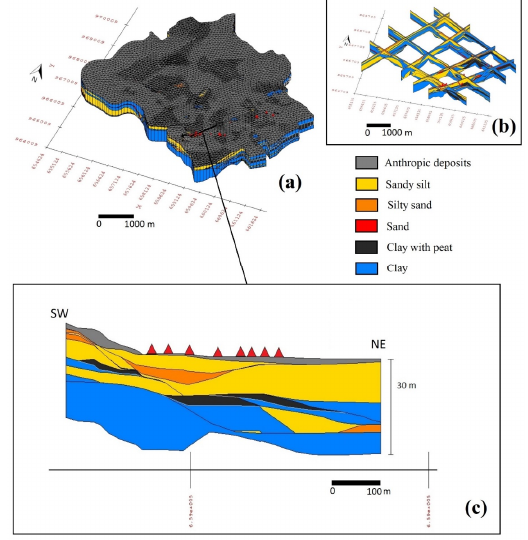
Figure 11. ( a ) The 3D engineering geological model of Cavezzo and fence diagram of geological sections, derived from the model showing the lithological variations. ( b ) Detail of a cross-section through the observed sand boils. ( c ) Liquefaction phenomena are represented as red triangles. Overall, the model displays a superficial coverage of sandy silt, with a higher content of fine with a thickness, ranging from 2 to 15 m. The higher thickness of these shallow deposits is observed in the floodplain. Below these deposits, sandy layers are present. These deposits are not laterally extended and mainly localized in the fluvial ridges and abandoned riverbeds at the plain level. The thickness of these soils ranges from about 4 to 6 m. The deeper deposits are constituted by clay and clay with peat, with the last one representing a marker layer, useful for the stratigraphic correlations. Over 15–20 m from the ground level, fine sandy soils are present, corresponding to the ancient fluvial channel deposits. Furthermore, the reliability of the 3D modelling has been assessed by performing a statistical analysis of the spatial distribution of the geotechnical investigations. The kernel density analysis has been implemented to estimate the density of the geotechnical inves- tigations in a neighborhood around these points [43]. A total of 33% of the study area is characterized by values from moderate to high density, and it is evident that the density of the data used to create the 3D engineering geological model is higher where the lique- faction phenomena were observed, and the geological setting is more complex, due to the deposits of the buried paleochannel of the Secchia River (Figure 12).